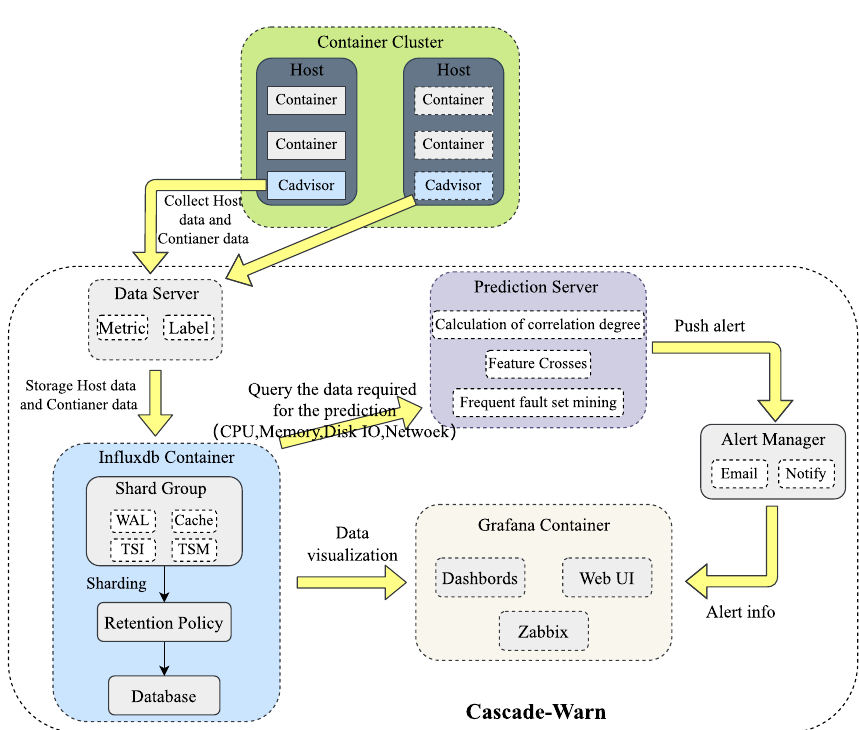
Fig. 10 Experimental prototype framework